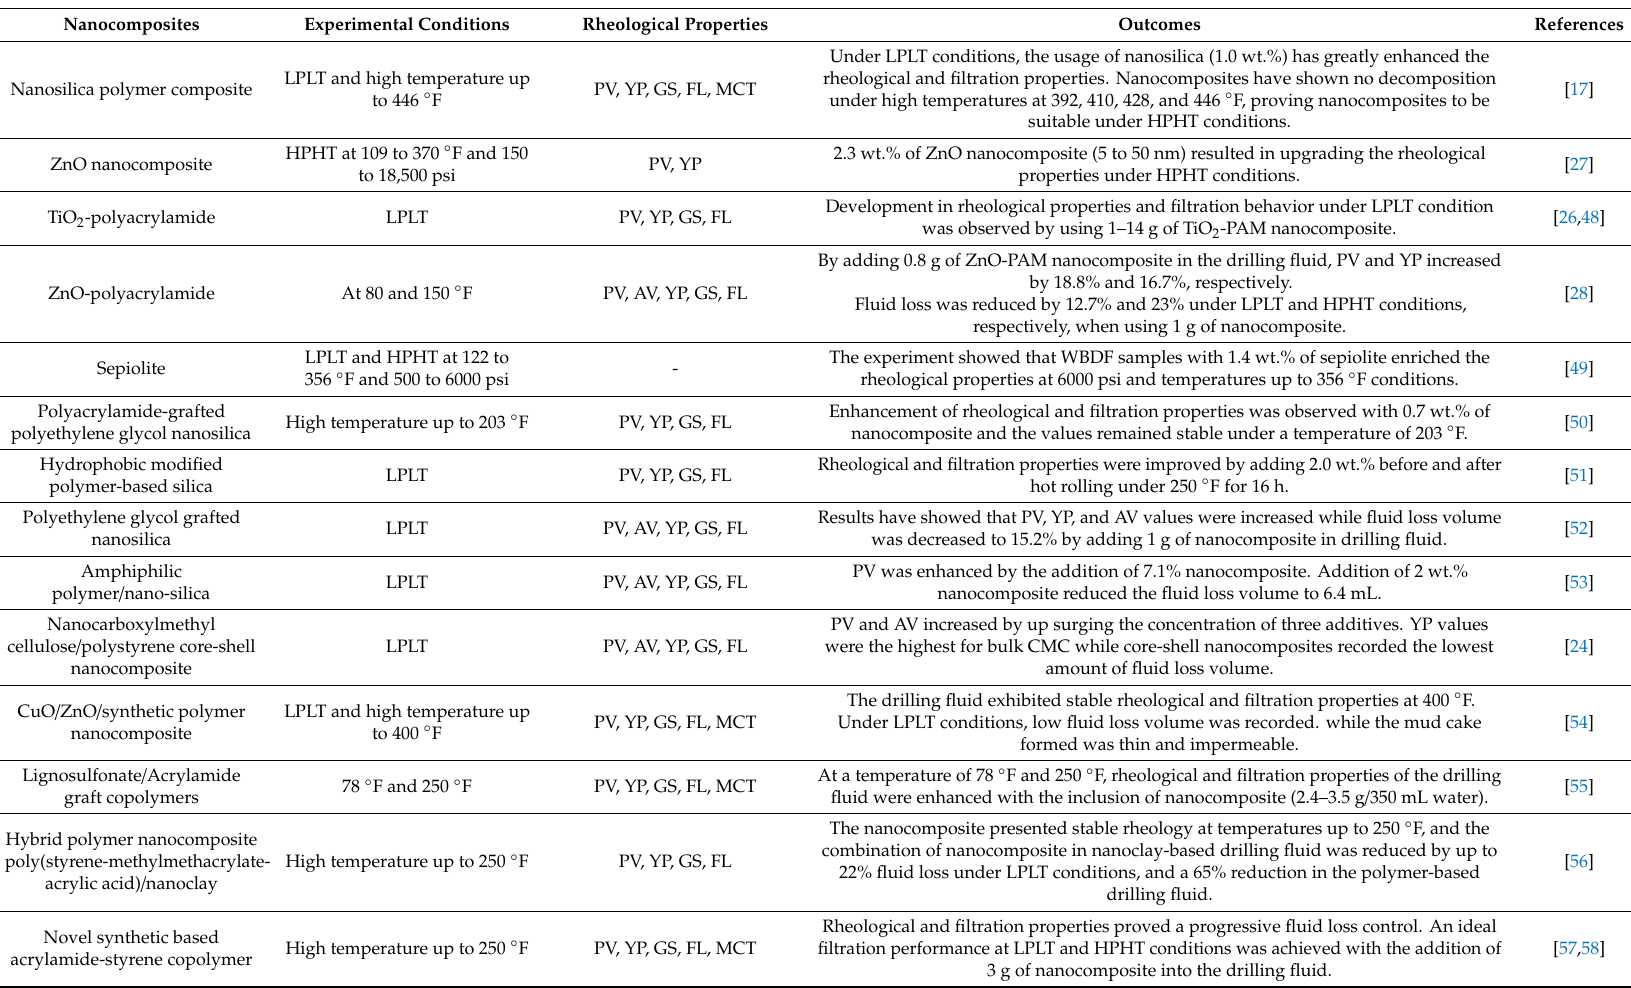
Table 1 includes the following designations: WBDF: water-based drilling fluids, LPLT: low pressure-low temperature, HPHT: high pressure-high temperature, PAM: polyacrylamide, CMC: carboxymethyl cellulose, PV: plastic viscosity, YP: yield point, GS: gel strength, FL: fluid loss, MCT: mud cake